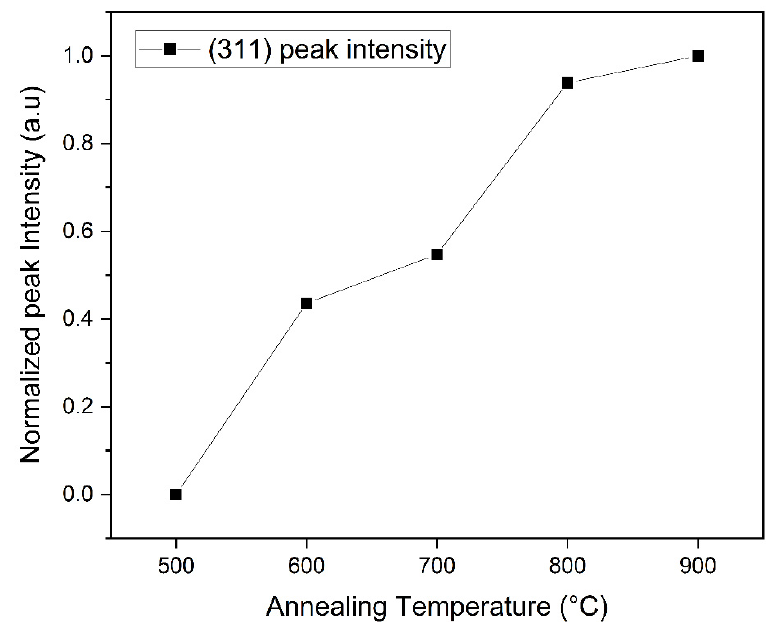
Figure 3. (311) peak intensity identified in the CuGa 2 O 4 films as a function of the annealing temperature.